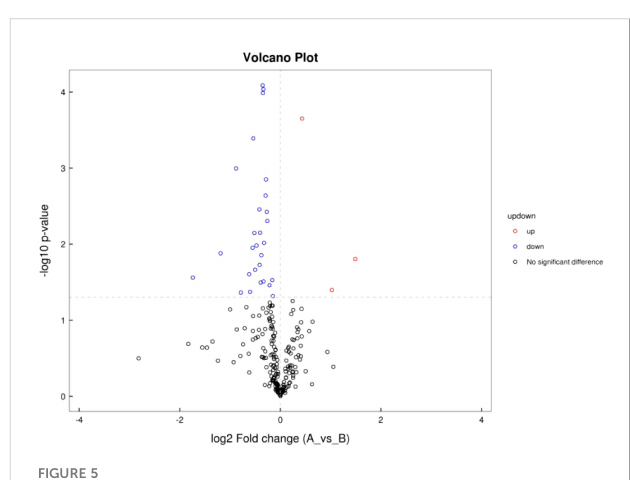
FIGURE 5 Volcano Plot of Ion Pattern for Treatment vs